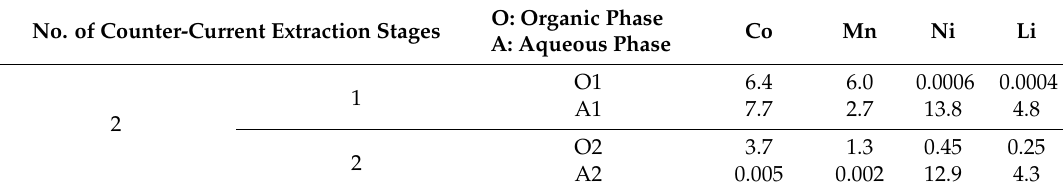
Table 4. The results of the counter current simulation extraction batch tests by 0.85 M Cyanex 272 with 50% saponification. Unit: g/L.